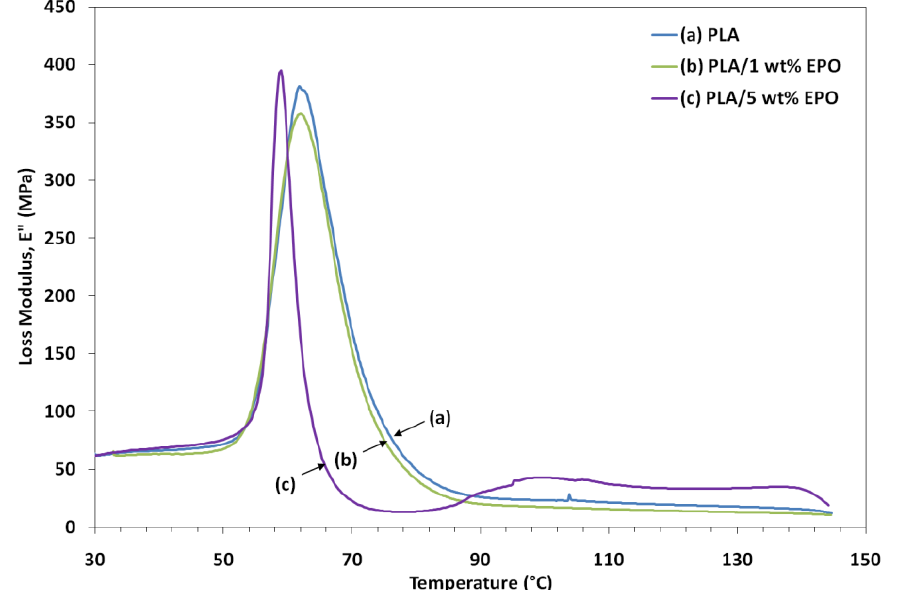
Figure 9. Loss modulus of neat PLA and PLA/EPO blends as a function of